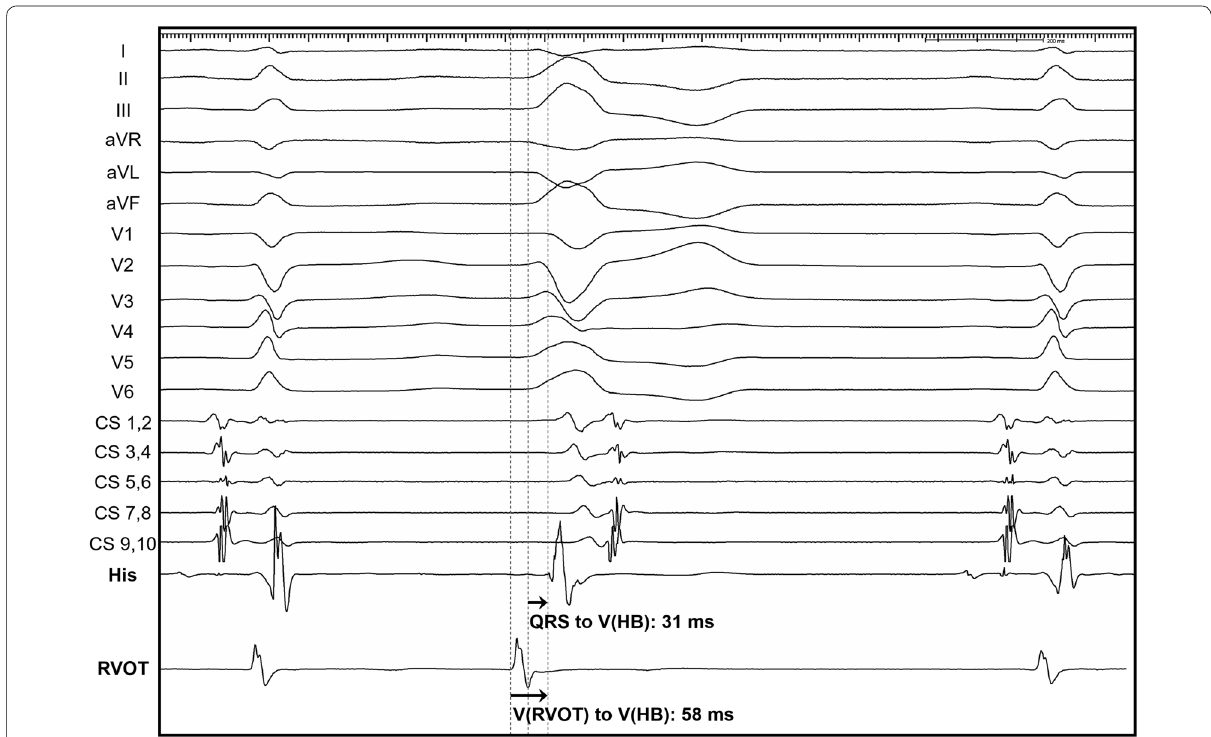
Fig. 2 Representative measurements of V(RVOT)‑V(HB) intervals (interval from the RVOT electrogram to the V signal in the His bundle electrogram) and QRS‑V(HB) intervals (interval from the onset of the earliest QRS complex in 12‑lead surface electrocardiogram to the V signal in the His bundle electrogram) in cases of ventricular arrhythmia originating from the